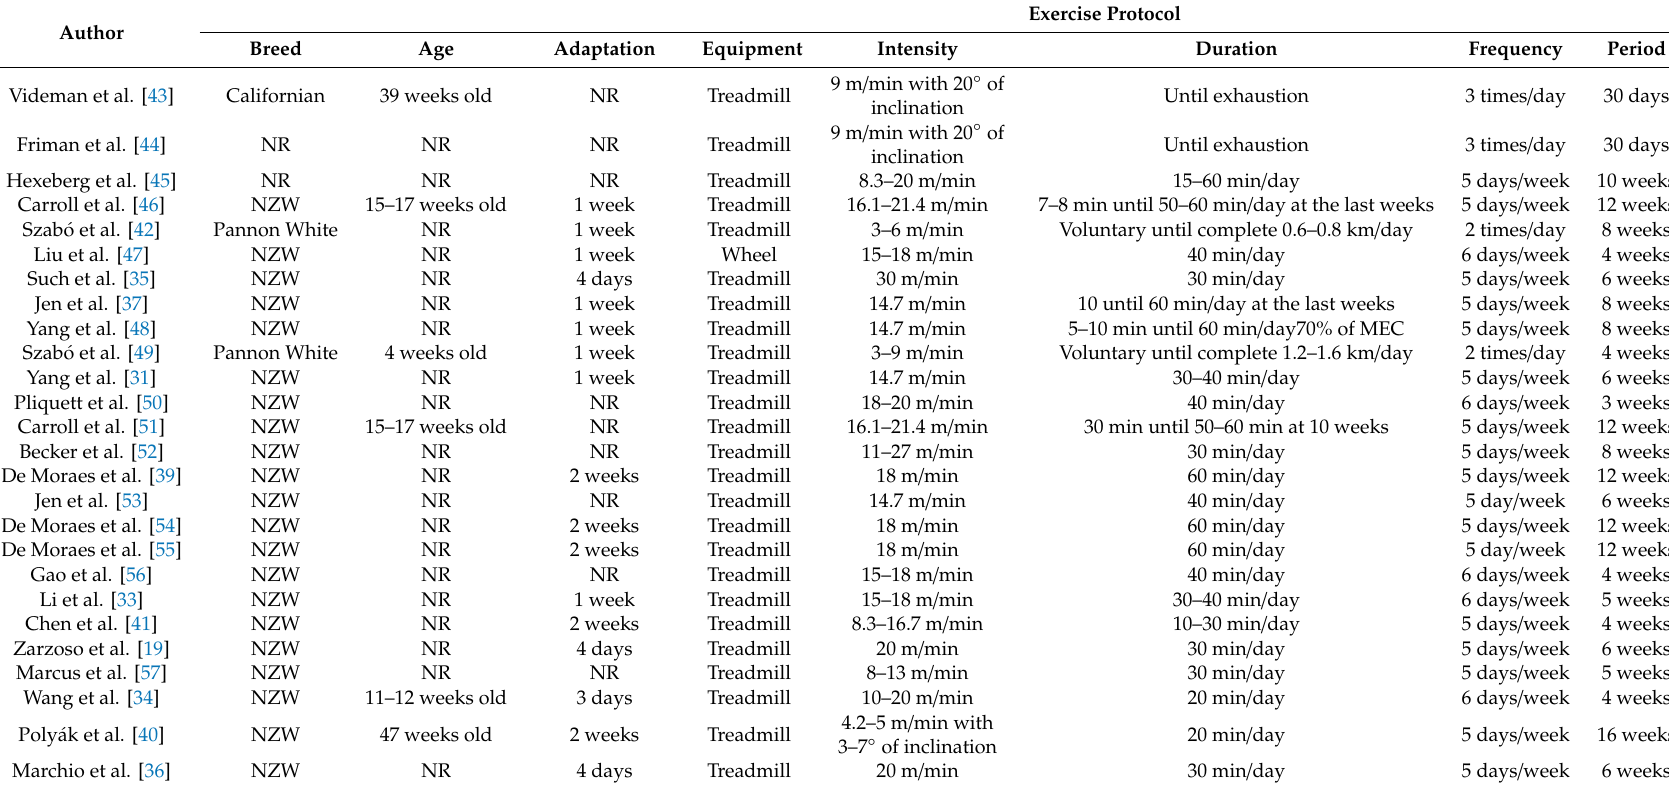
Table 2. Protocols of chronic exercise training in